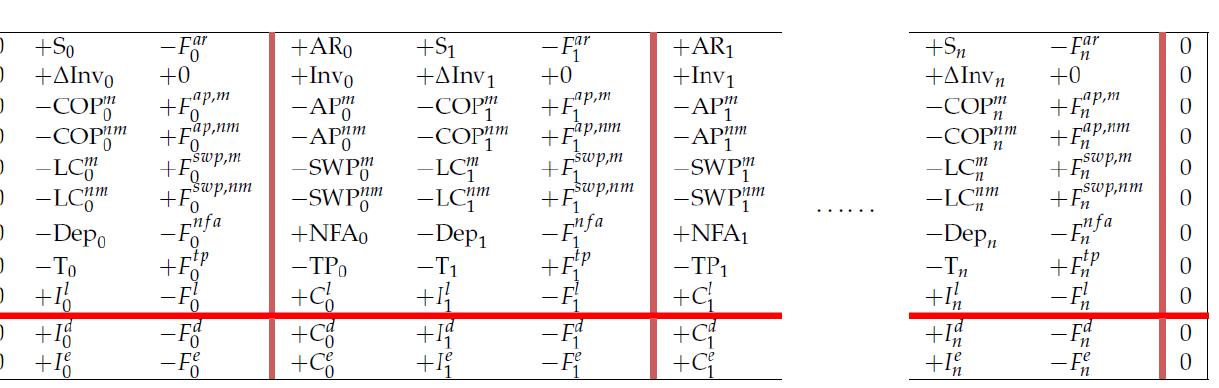
Figure 7. The full-scale strip (reprinted from Part I, Equation (68)). CODE INSTRUCTIONS: STRUCTURE OF THE SPLIT-SCREEN STRIP